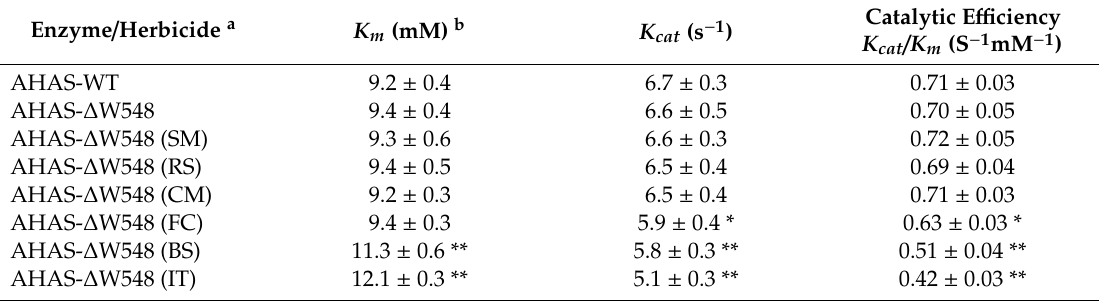
Figure 4. Bioassay curves of AHAS activities in the presence of six herbicides. AHAS-WT was inactive when an herbicide was more than 10 μ M. AHAS- Δ W548 remained active at high concentrations of herbicides. Panels of ( a )–( f ) displayed the AHAS remaining activities in solutions of different herbicides: ( a ) sulfometuron-methyl (SM), ( b ) rimsulfuron (RS), ( c ) chlorimuron-methyl (CM), ( d ) flucarbazone-sodium (FC), ( e ) bispyribac-sodium (BS), and ( f ) imazethapyr (IT). Error bars represented the errors from triplicate measurements. Triangles are AHAS-WT, and circles are AHAS- Δ W548. Table 2. Kinetic parameters of the AHAS-WT and AHAS- Δ W548 enzymes.